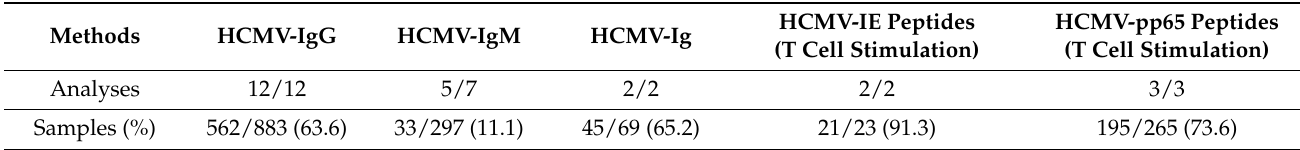
Table 9. Summarized results from published studies on HCMV serology using ELISA and T-cell reactivity against HCMV peptides using FACS in GBM patients.